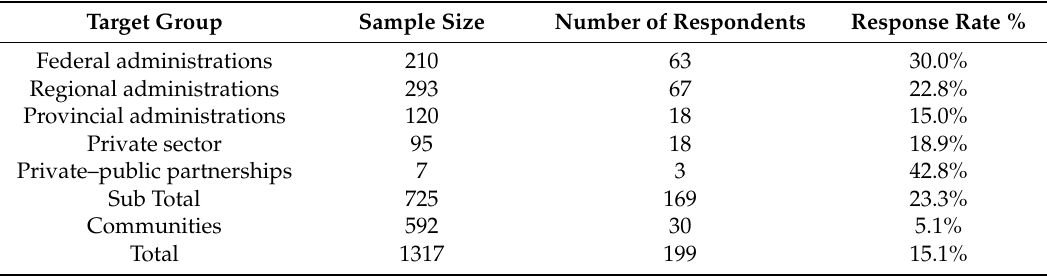
Table 3. Online survey response data according to targeted